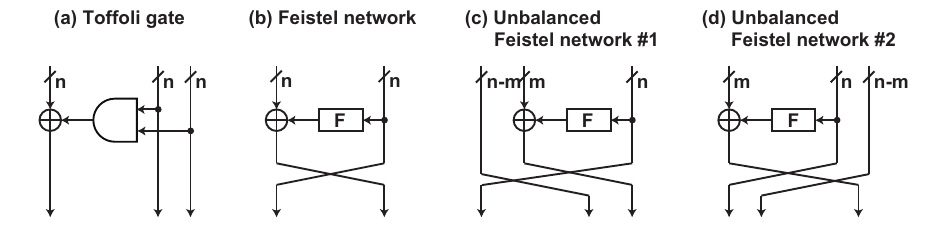
Figure 3: Construction of invertible functions from